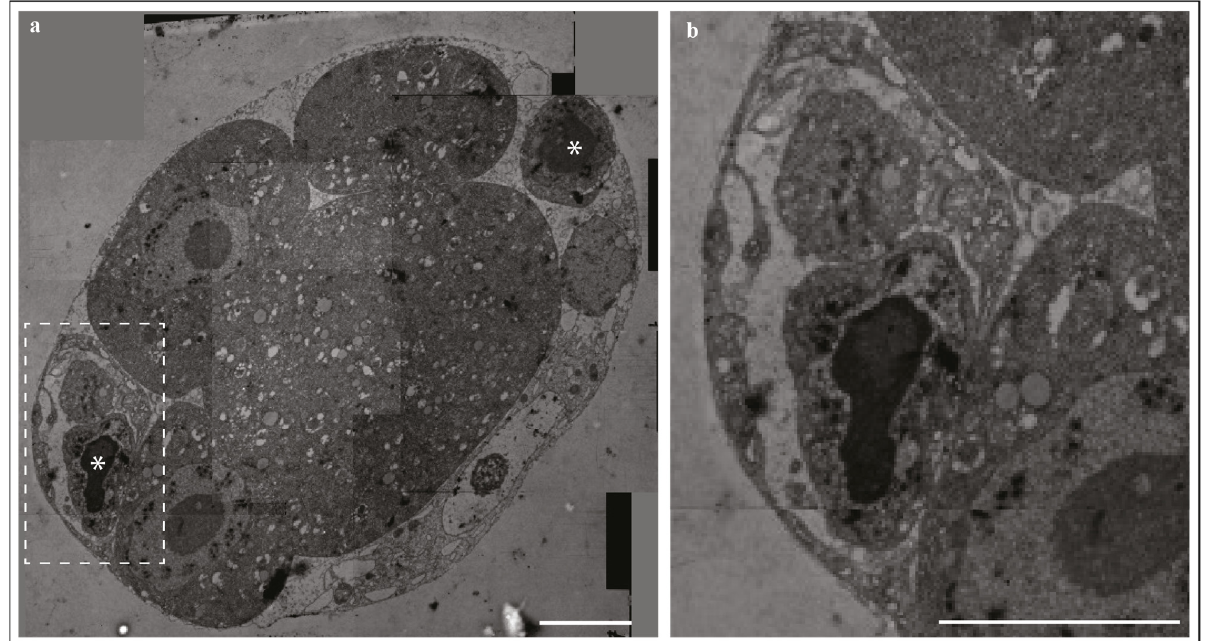
Figure 1. Dying C. elegans germ cells show ultrastructure characterization of apoptotic cells. ( a ) Cross-section of the isolated C. elegans germline, 24 h after gamma radiation. Two cells undergoing apoptosis (marked with asterisks) exhibit the typical feature of apoptosis and are engulfed with the neighboring cell. The chromatin is highly condensed, and the nucleus is cellularized. ( b ) Magnification of the box shows the complete engulfment of the corpse. Scale bar: 5 µ m (Image courtesy of Ehsan Pourkarimi and Anton Gartner, Center for Gene Regulation and Expression, University of